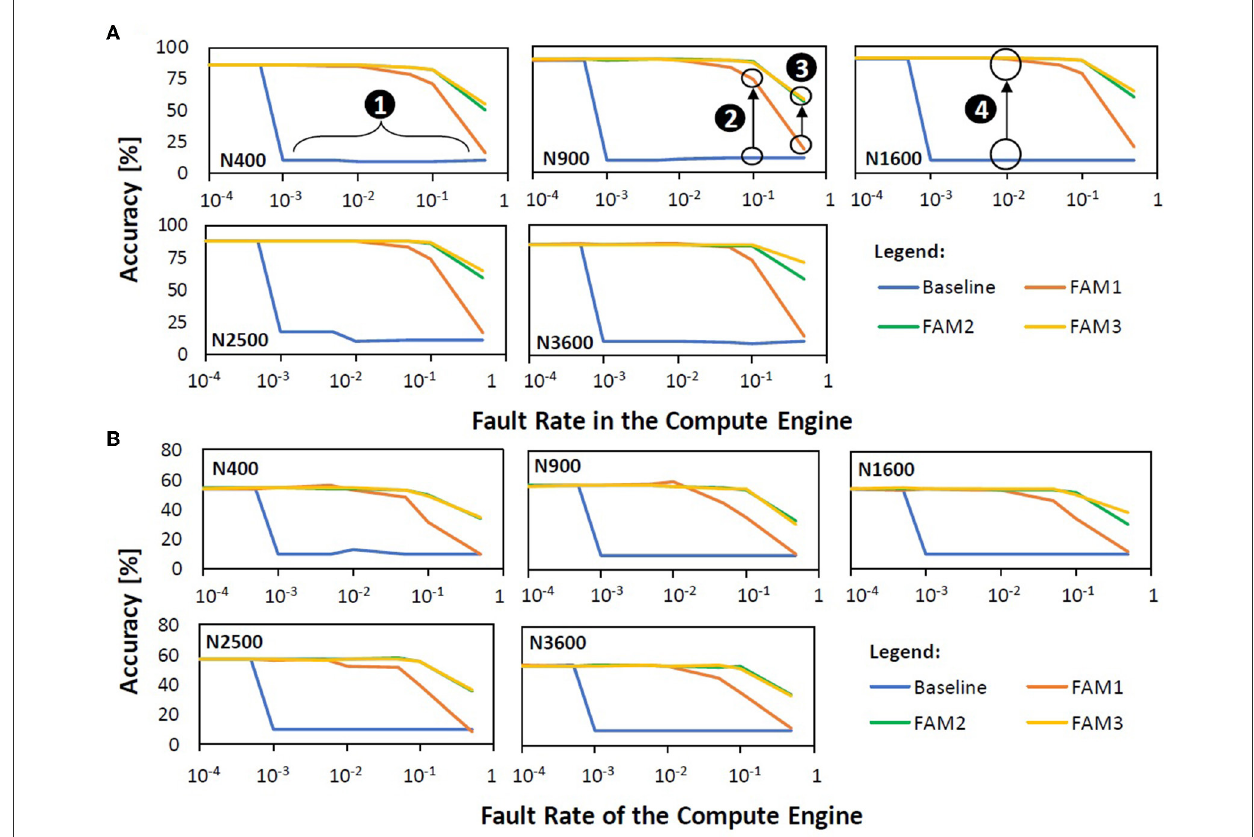
FIGURE14 Accuracy profiles for different mitigation techniques (i.e., baseline, FAM1, FAM2, and FAM3), different model sizes (i.e., N400, N900, N1600, N2500, and N3600), different fault rates, and different workloads: (A) MNIST and (B) Fashion MNIST.